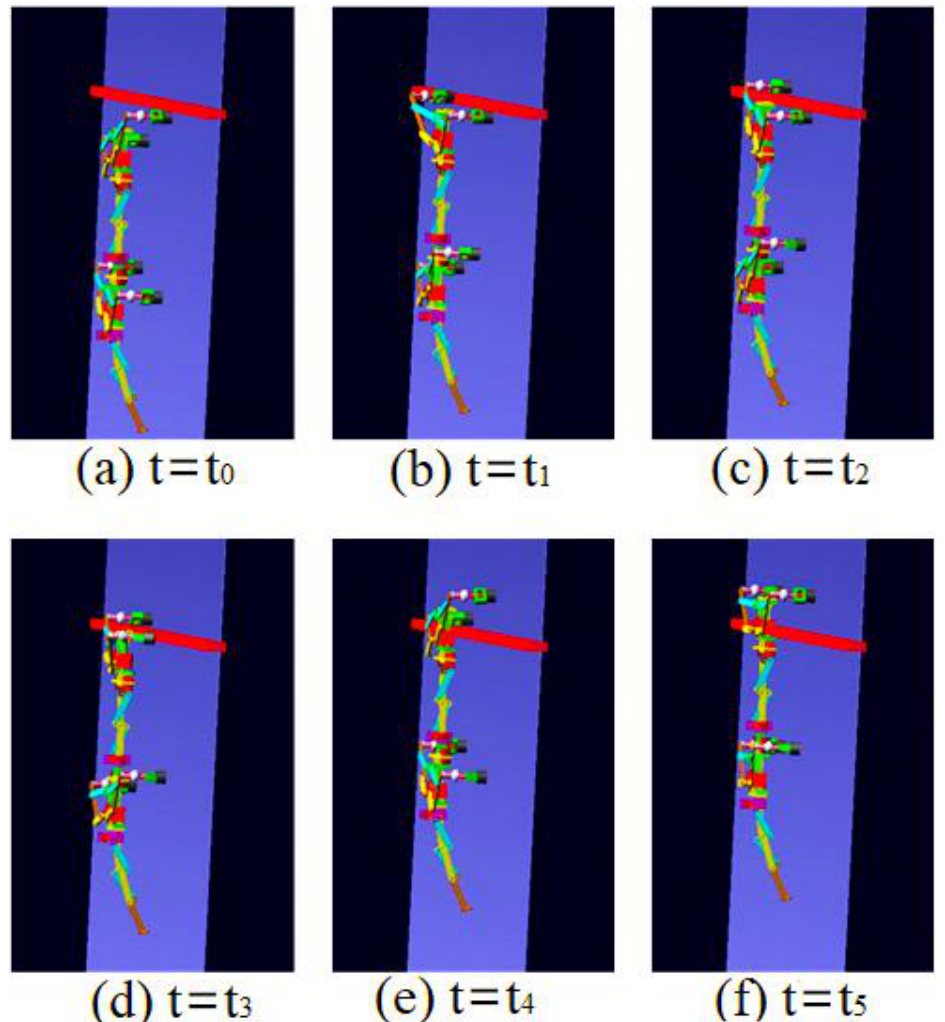
Figure 12. Movement of the robot using diagonal gait when crossing obstacle in ADAMS in differ- ent moments.